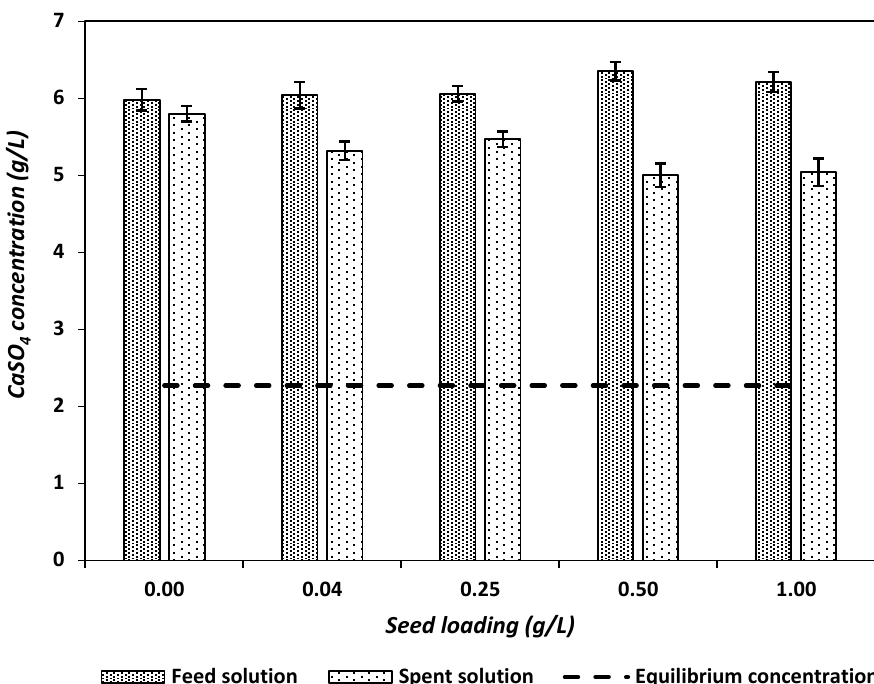
Figure 7. CaSO 4 concentration in solutions as a function of gypsum seed loading.